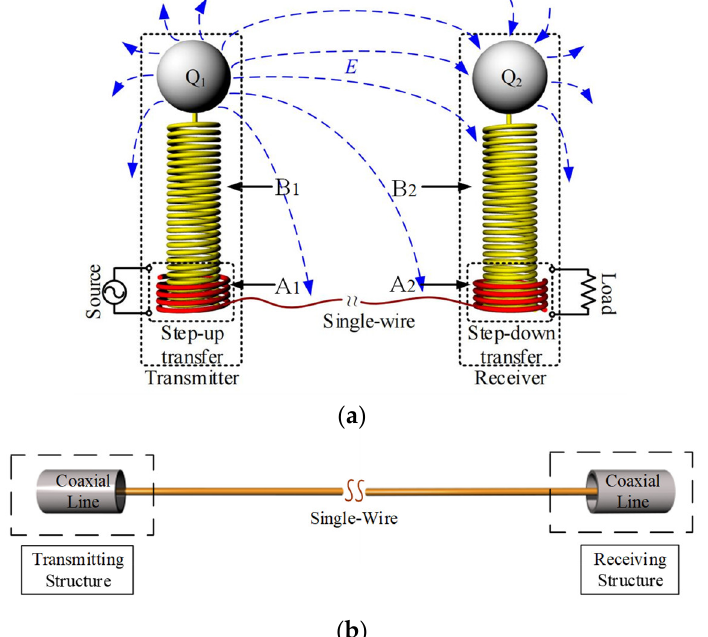
Figure 1. Single-wire power transfer systems: ( a ) traditional single-wire power transfer system; ( b ) one-way single-wire power transfer system.